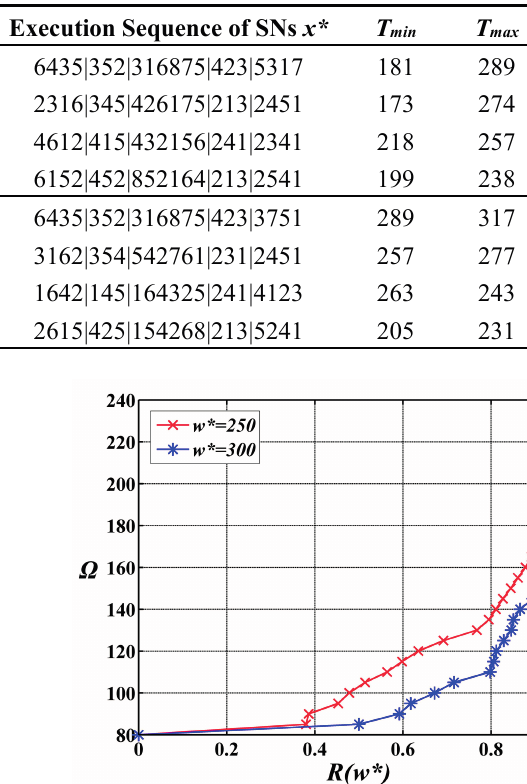
Table 3. Parameters of solutions obtained for w * = 250 and w * = 300.